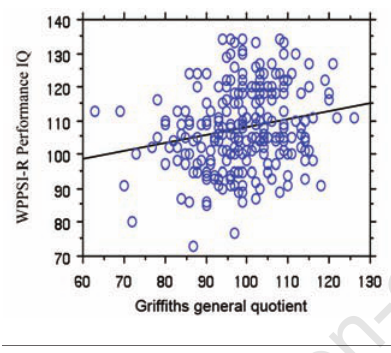
Figure 2. Regression plot of WPPSI-R per- formance IQ and Griffith general quotient.